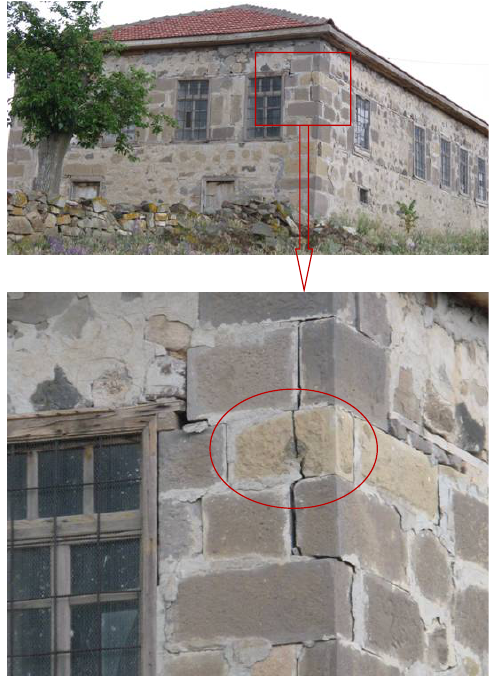
Fig. 14. Examples of diagonal shear cracking on the structural Fig. 14 Examples of diagonal shear cracking on the structural walls walls.